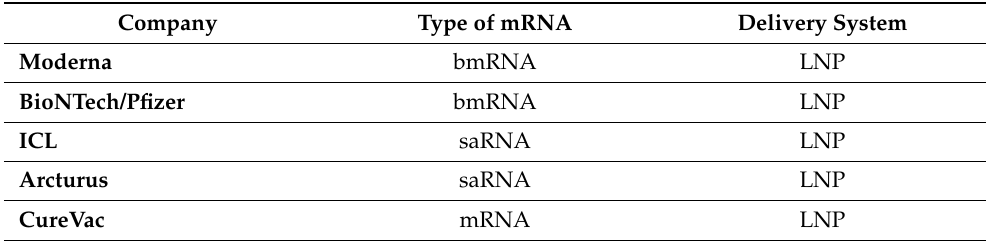
Table 7. Summary of mRNA-based vaccines against the SARS-CoV-2 virus (modified from [162]; original paper under the terms of the Creative Commons CC BY-NC 3.0).